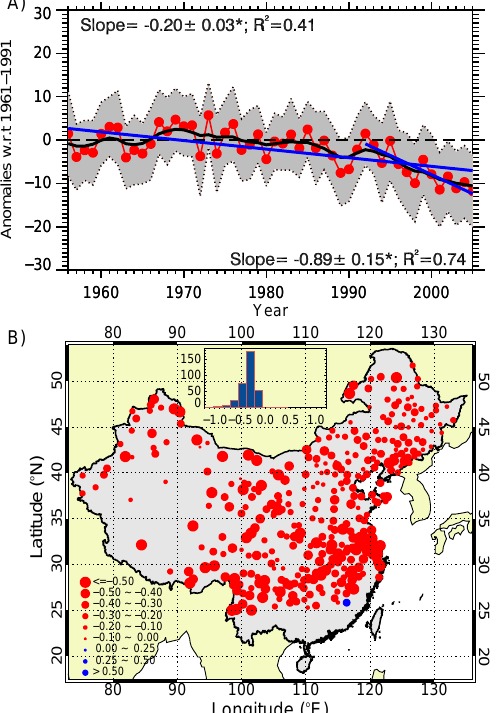
Figure 5. Same as Fig. 3 except for the duration of the near-surface soil freeze.